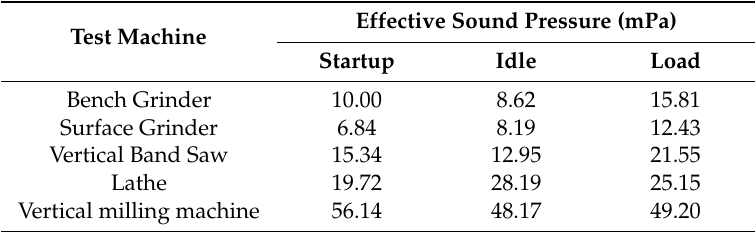
Table 3. Effective sound pressures for all 5 test machines at startup, idle and during load.